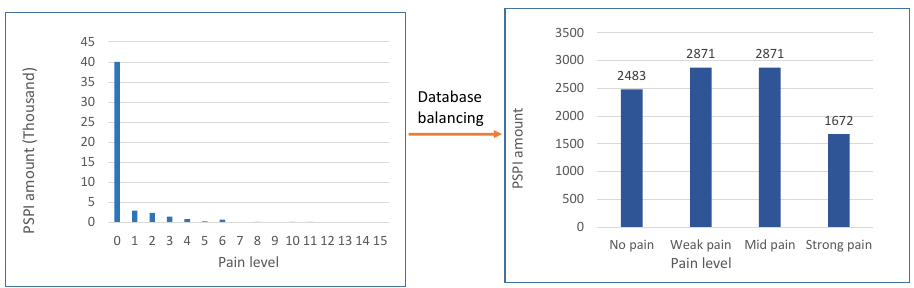
Figure 4. Amount of PSPI for each pain level on both balanced and imbalanced UNBC McMaster